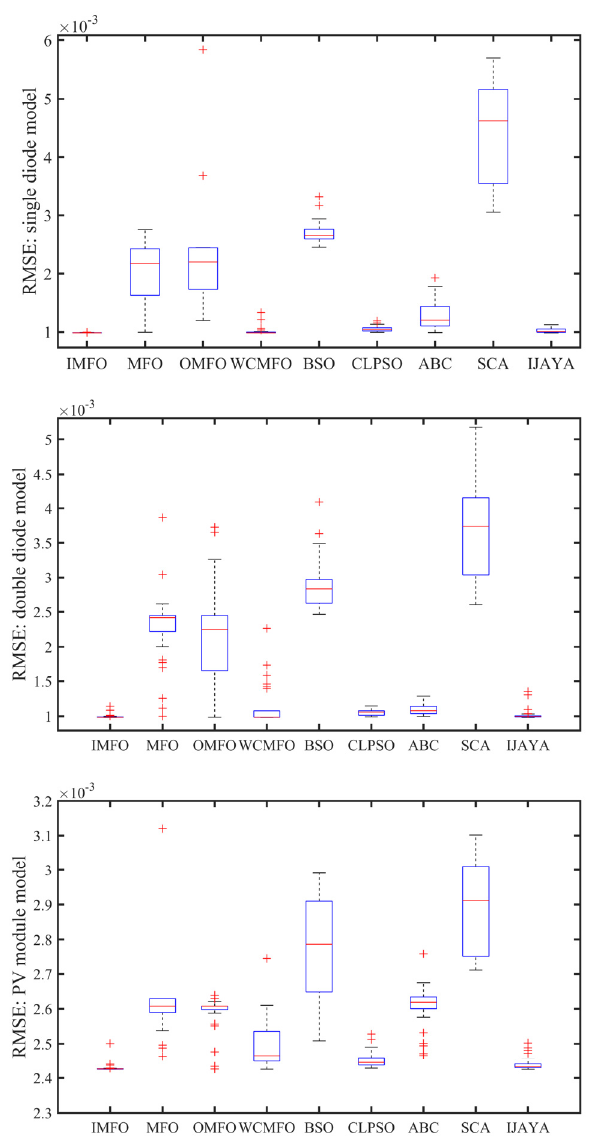
Figure A4. Best RMSE boxplot over 30 runs of different algorithms for three models.